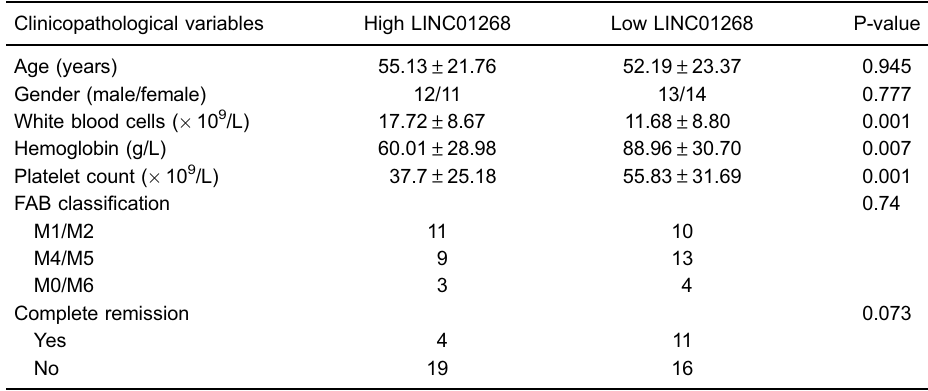
Table 1. Correlation between LINC01268 expression and clinical characteristics of acute myeloid leukemia patients. Clinicopathological